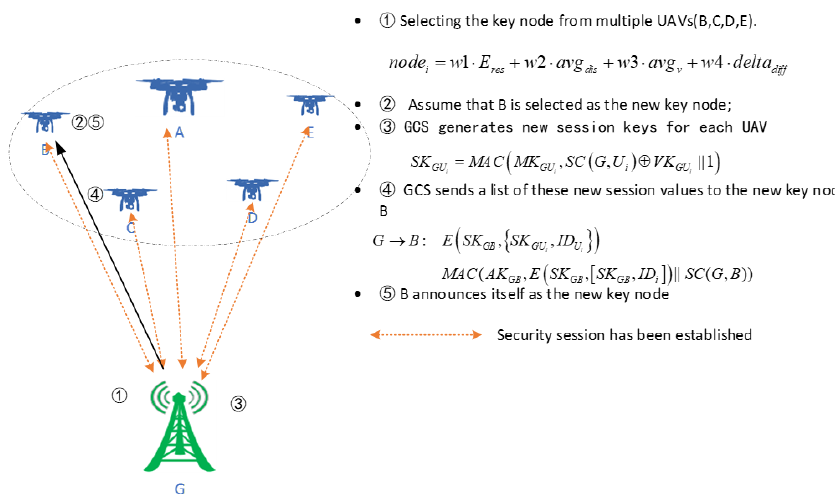
Figure 4. Selection of the key node.